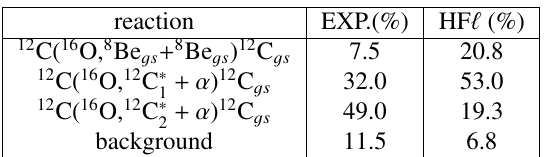
Table 1. Experimental branching ratios of di ff erent reactions compared to HF (cid:28) predictions. C ∗